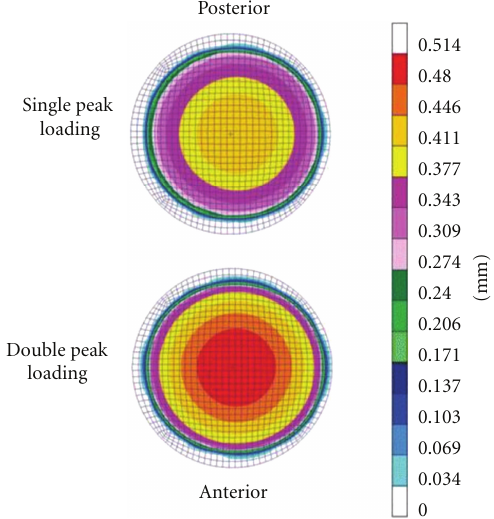
Figure 8: Linear wear contour predicted for ProDisc-L using finite element technique. Adapted from